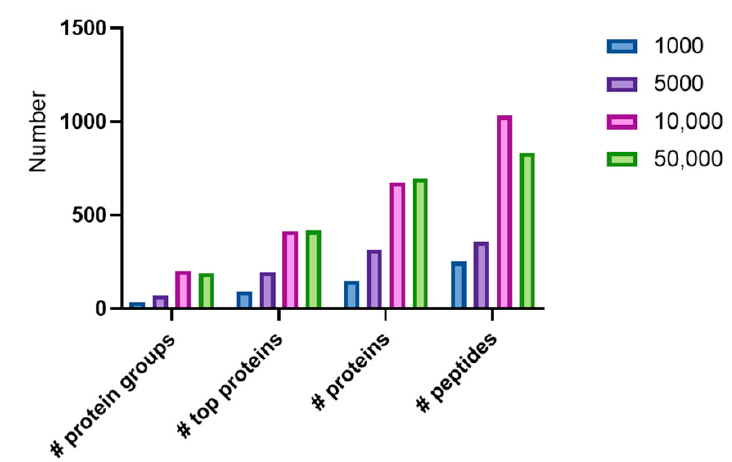
Figure 4. Overview of the number of protein groups, top proteins, proteins, and peptides identified with Peaks X + in FACS sorted samples on the 1000, 5000, 10,000, and 50,000 cell samples.